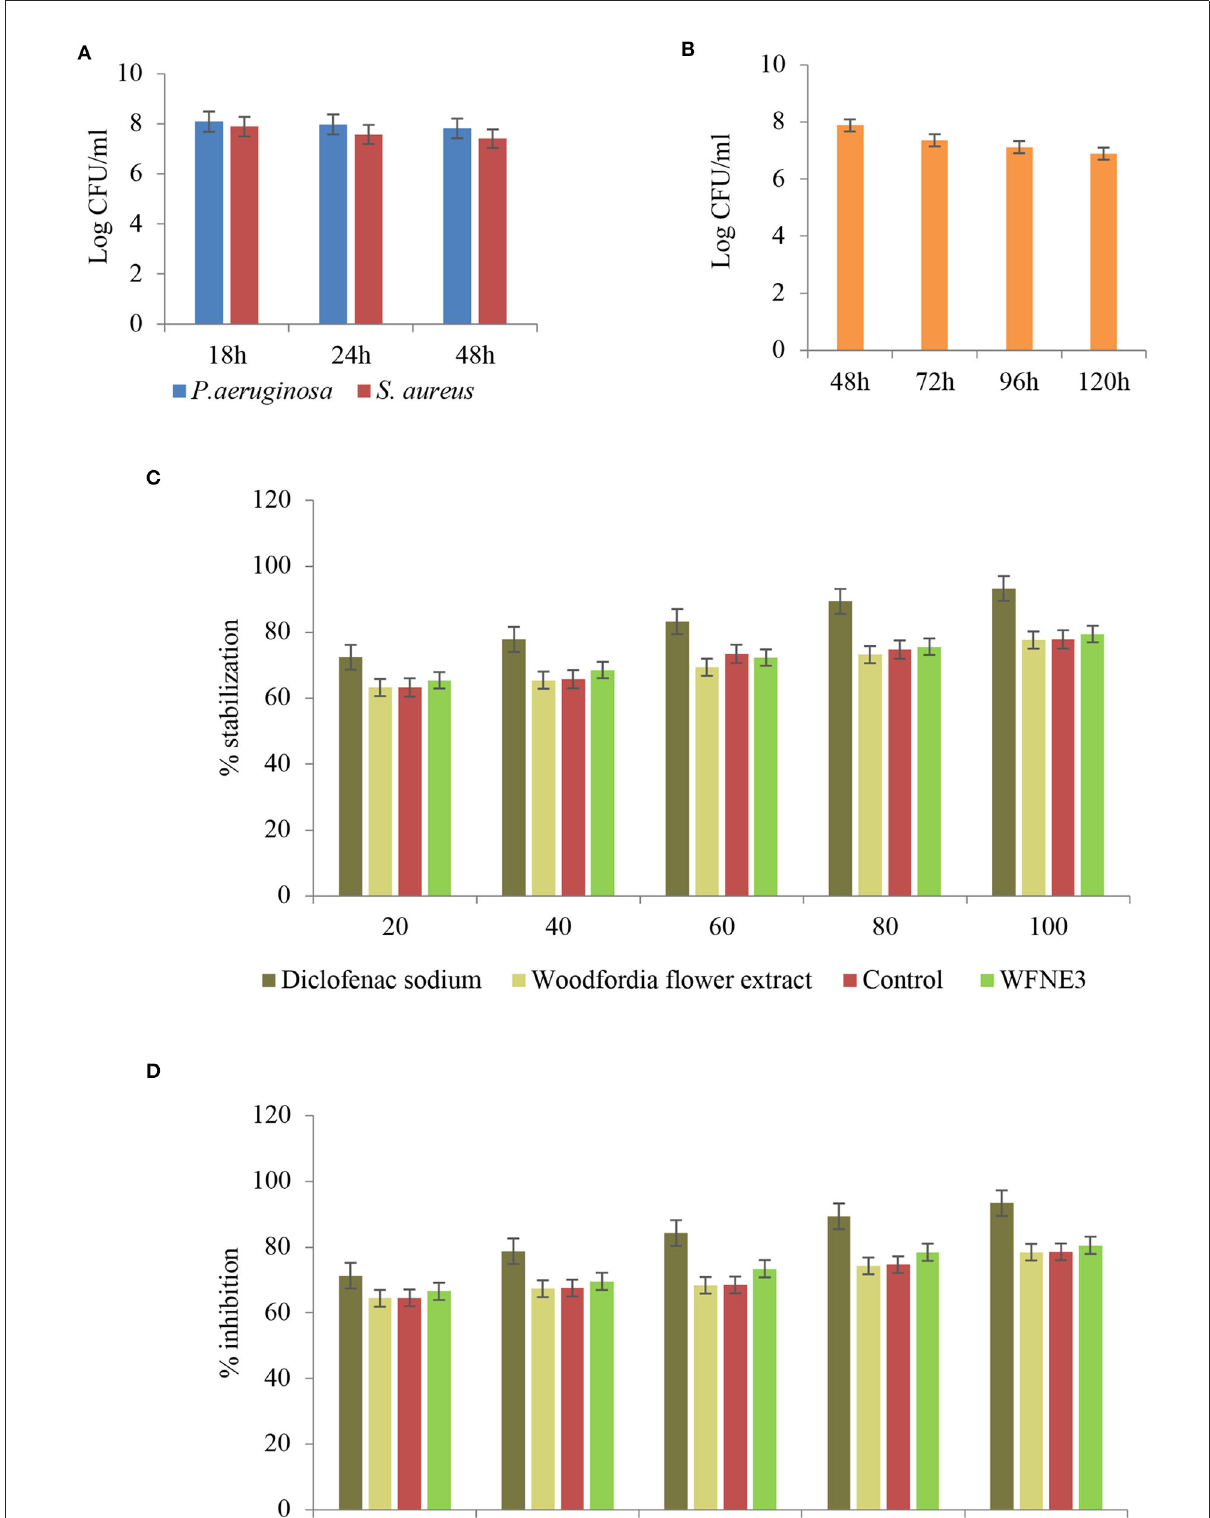
FIGURE6 Time kill kinetics of WFNE3 nanoemulsion against ( A ) S. aureus and P. aeruginosa, ( B ) C. albicans, ( C ) Anti-inflammatory activity of WFNE3 nanoemulsion with HRBC membrane stabilization, and ( D) Anti-inflammatory activity of WFNE3 nanoemulsion using BSA denaturation